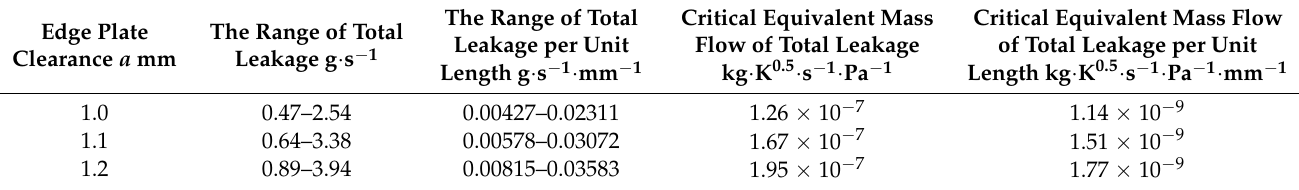
Table 2. The range of total leakage and the critical equivalent mass flow of total